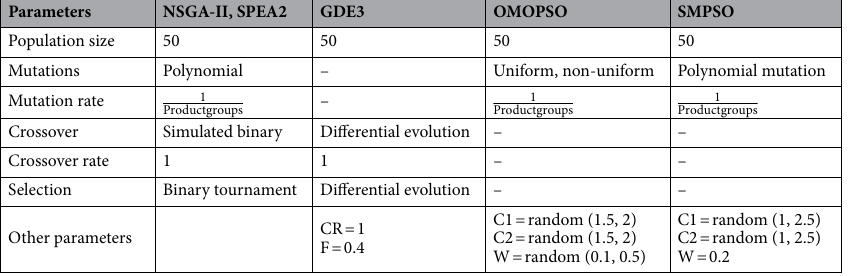
from the existing swarm. Save the leaders in the Pareto archive. Initialize generations, G = { 1, 2, . . . , G max } .